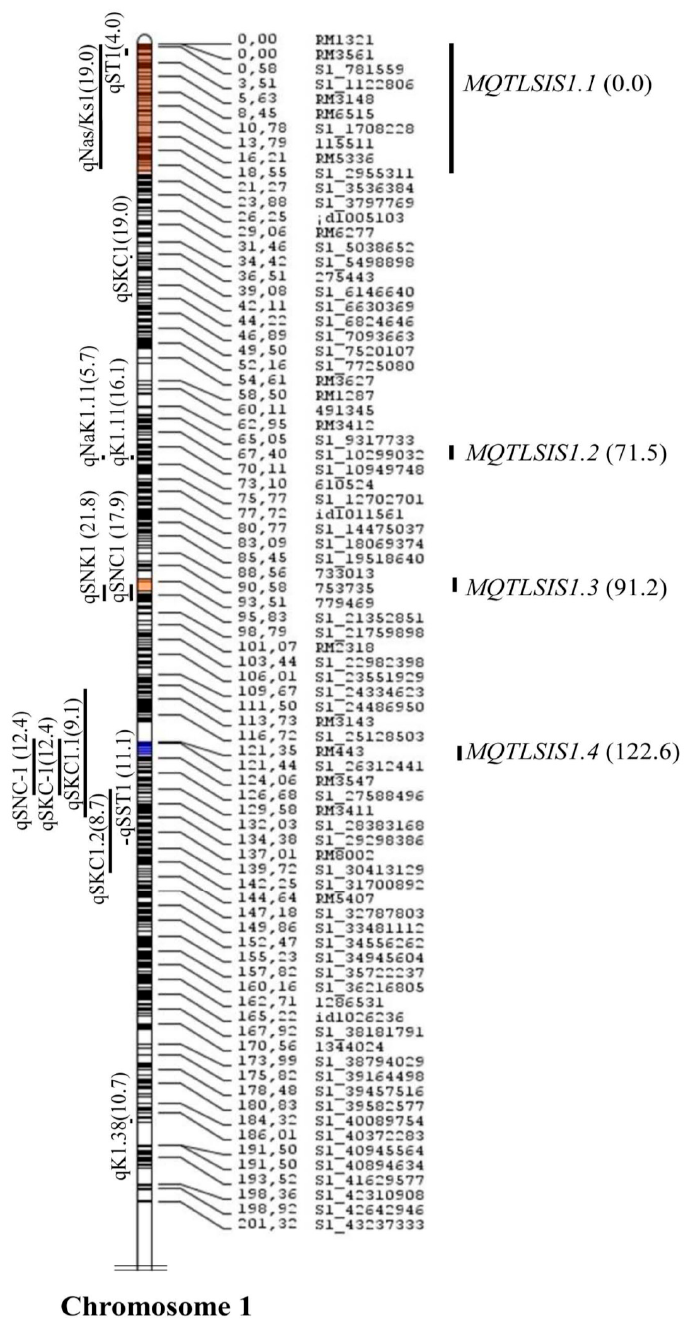
Figure 2. Meta-QTLs for salt injury score (SIS) in rice on chromosome 1. Vertical lines on the left of the chromosomes show the confidence interval of each QTL and values in parentheses indicate the percentage of phenotypic variation explained by these QTLs. Four meta-QTLs for SIS were shown on the right of the chromosomes, with the confidence interval indicated by vertical bars and the peak position of the meta-QTLs in cM on the consensus map (in parenthesis).